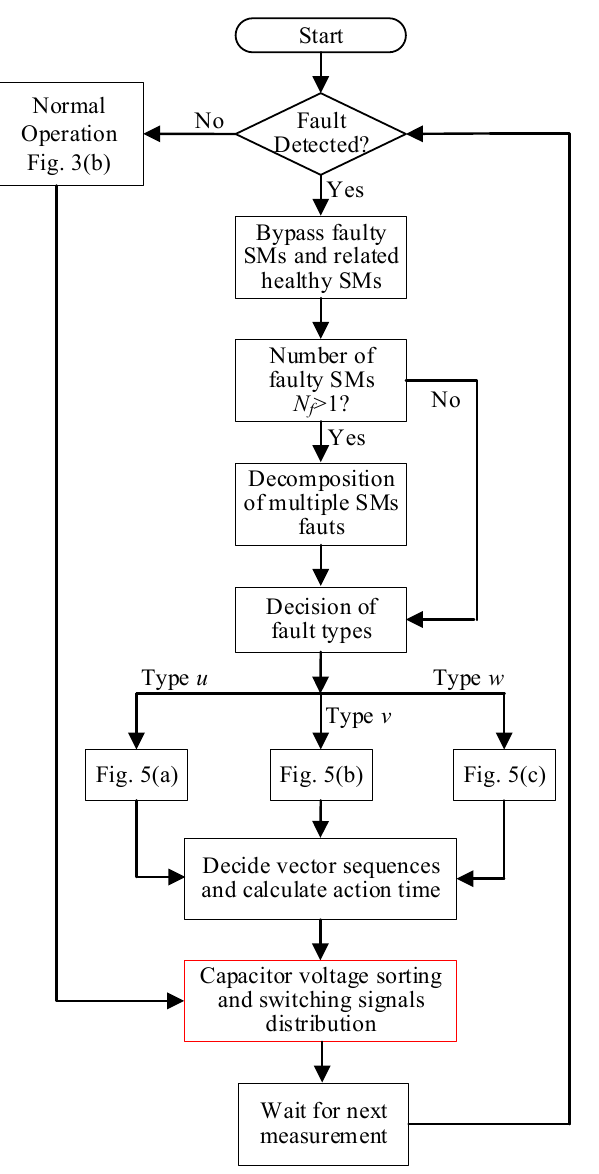
Figure 8. Flow chart of the presented FT strategy.